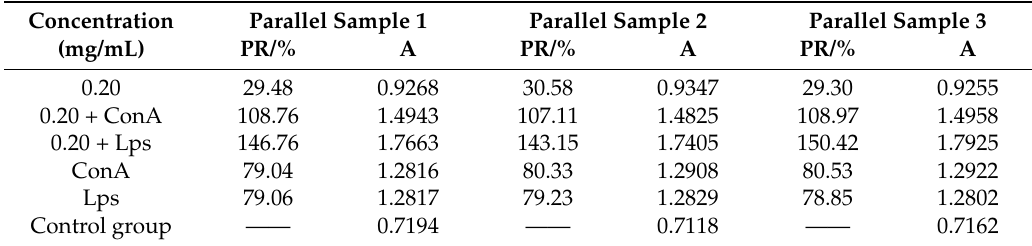
Table 5. Effect of adding ConA and Lps on mouse spleen cell proliferation.